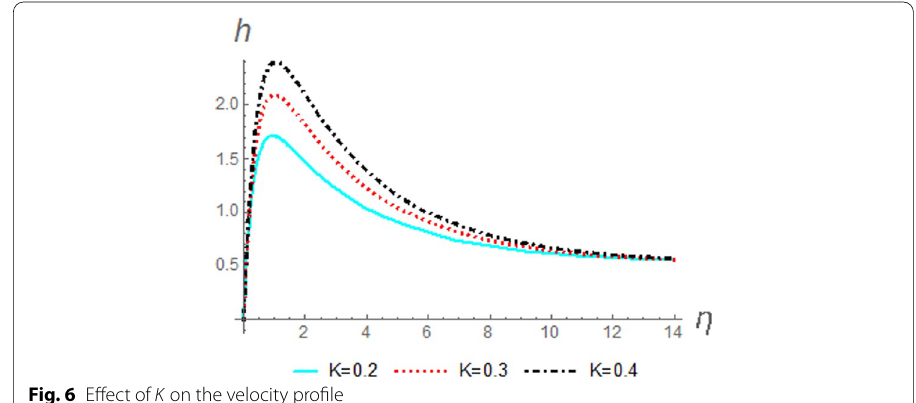
Fig. 6 Effect of K on the velocity profile